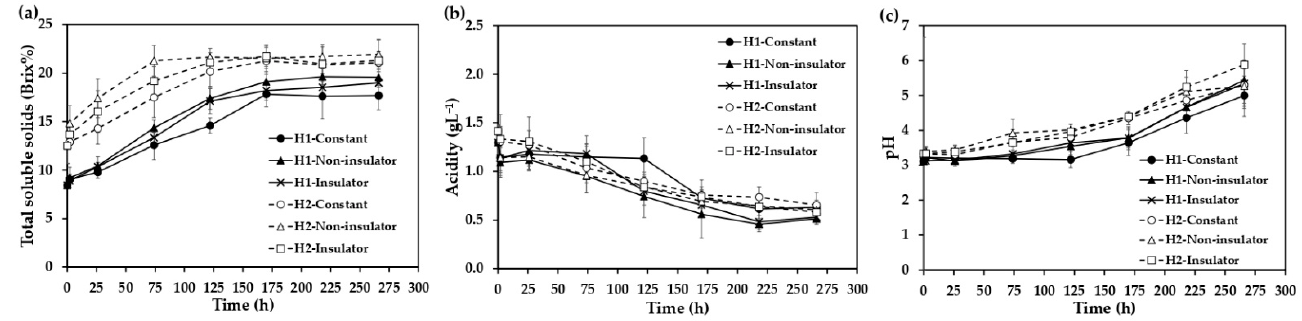
Figure 5. ( a ) Total soluble solids, ( b ) acidity, and ( c ) pH of mango fruits (‘Nam Dok Mai Si Thong’) under constant, non-insulated, and insulated conditions during simulated handling at the tarmac. After simulated handling at the tarmac, mango fruits from the first and second harvests were transferred to 20 °C for 266 h . H1, first harvest; H2, second harvest. Vertical bars on the graph indicate S.D. ( n = 5).